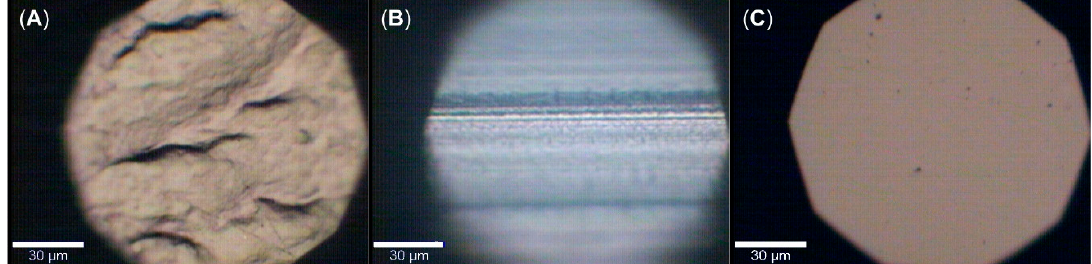
Figure 2. Micrographs of the inner surface of ( A ) polyvinylchloride (PVC), ( B ) polytetrafluoroethylene (PTFE), and ( C ) thermoplastic olefin (TPO)